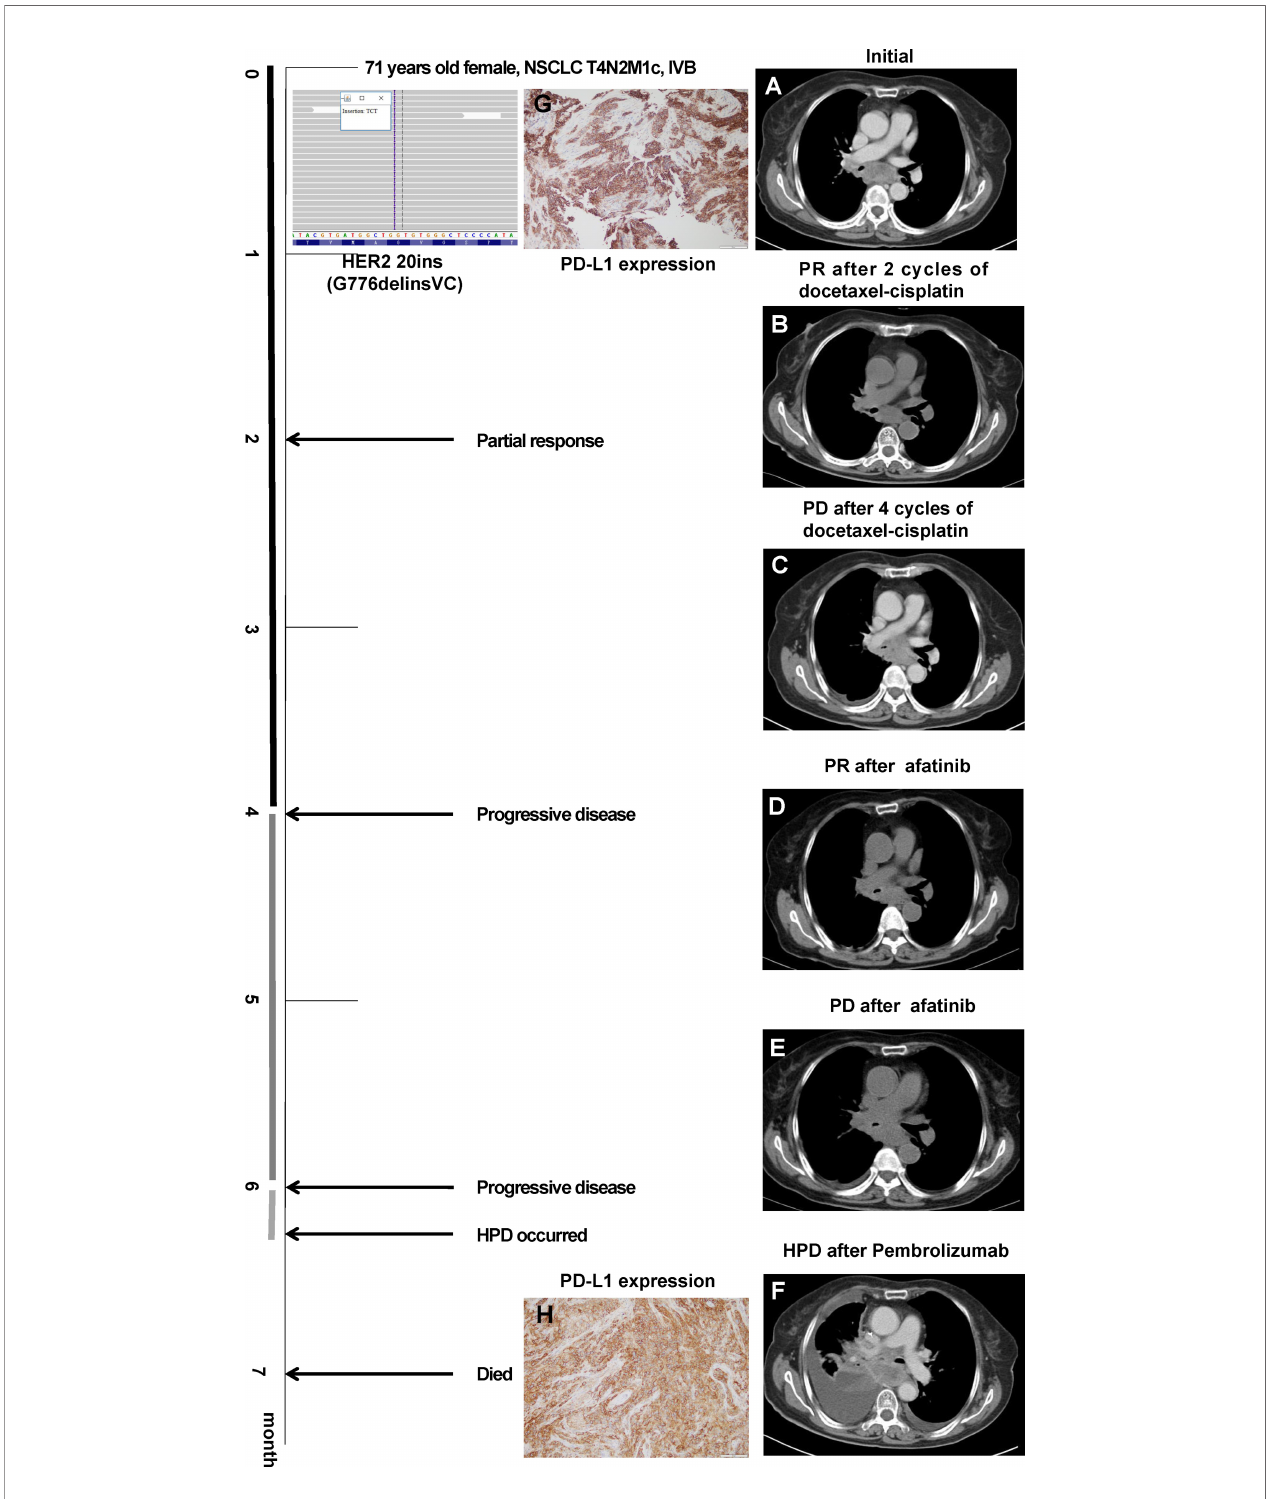
FIGURE 1 | Chest CT images throughout the disease course. (A) Initial evaluation showed enlarged mediastinal lymph node. (B) Partial response (PR) after docetaxel-cisplatin. (C) Progressive disease after four cycles of docetaxel-cisplatin. (D) PR after afatinib. (E) Progressive disease after 2 months of afatinib. (F) Hyperprogressive disease after one cycle of pembrolizumab. PD-L1 expression before (G) and after (H) pembrolizumab monotherapy.